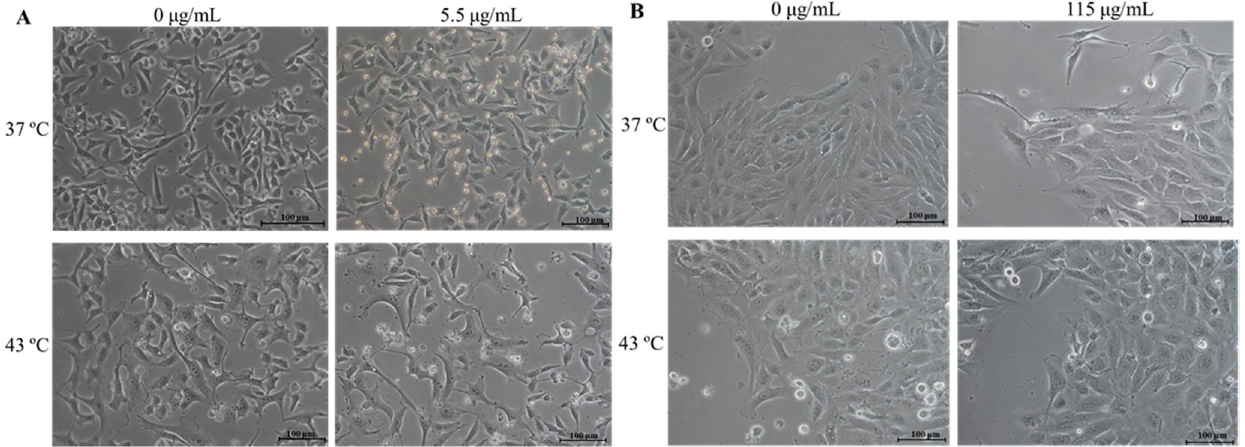
Figure 4. Effect of hyperthermia plus DTIC on morphology of A375 and MNT-1 cells. Cell lines were treated with 43 °C for 30 min and 5.5 μ g/mL or 115 μ g/mL of DTIC, in case of A375 or MNT-1 cells, respectively. ( A ) A375 cells; ( B ) MNT-1 cells.